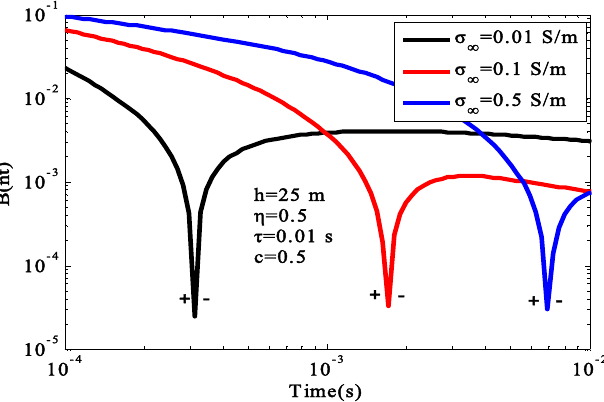
Figure 9. Response curves under different conductivities. Appl. Sci. 2020 , 10 , 1027